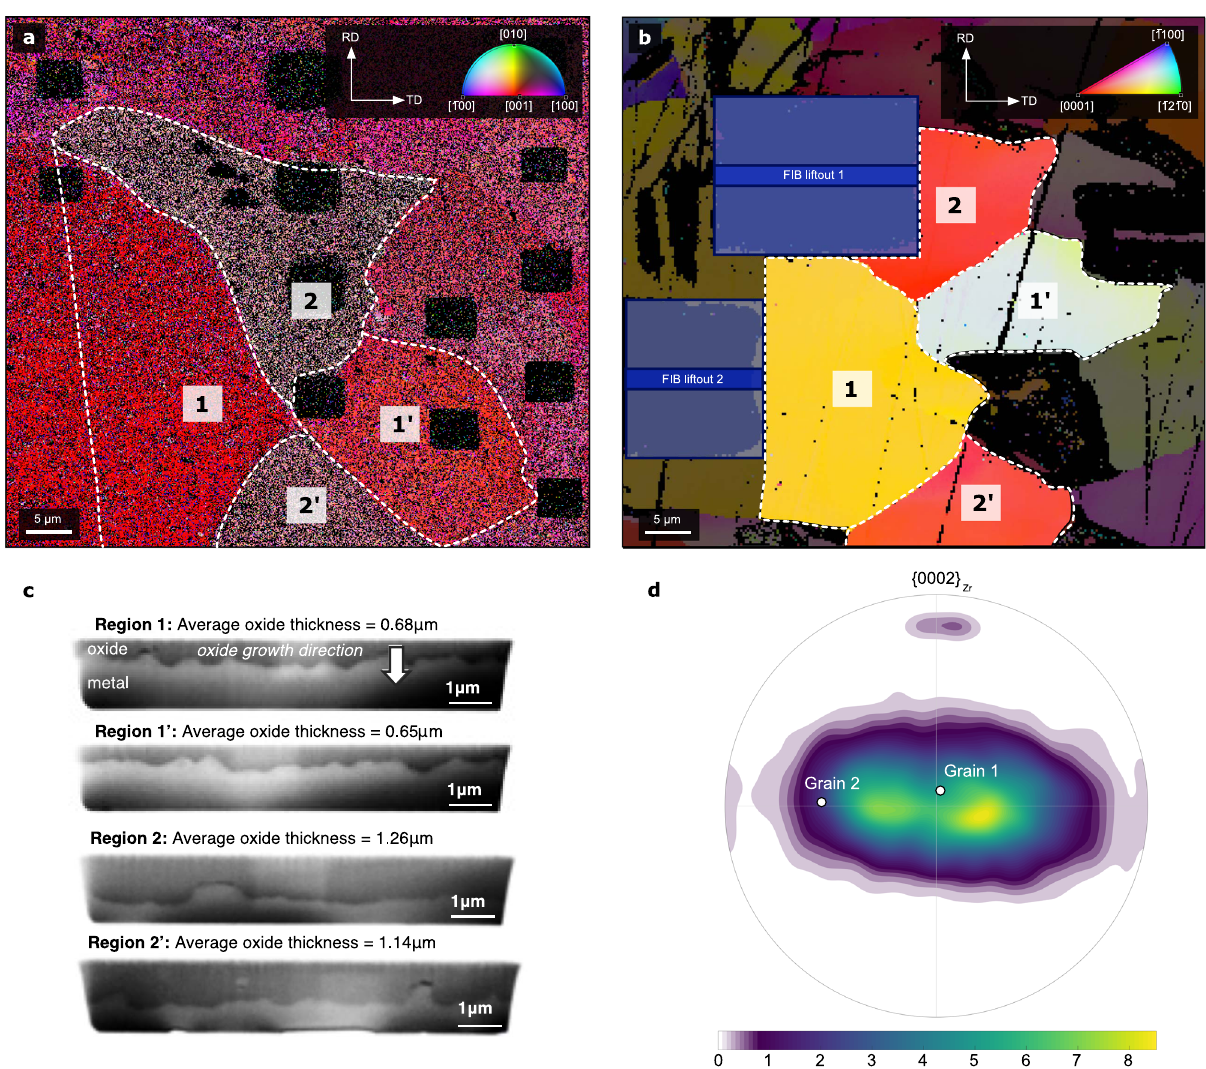
Fig. 1 | Electron backscatter diffraction orientation maps. EBSD orientation maps in inverse pole fi gure colouring relative to ND for a monoclinic ZrO 2 and b correspondingmetalgrainsaftermechanicalremovalofoxide.Oxideregionsand metal grains for subsequent orientation analysis are labelled as 1, 2, 1 ’ and 2 ’ . Ori- ginal rolling (RD) and transverse (TD) directions are marked on the fi gures. FIB liftoutpositionsforSPEDanalysisfromregions1 and 2areshownin b .SEMimages acquiredfromFIBtrenchesfromeachoxideregionareshownin c ,wheretheoxide